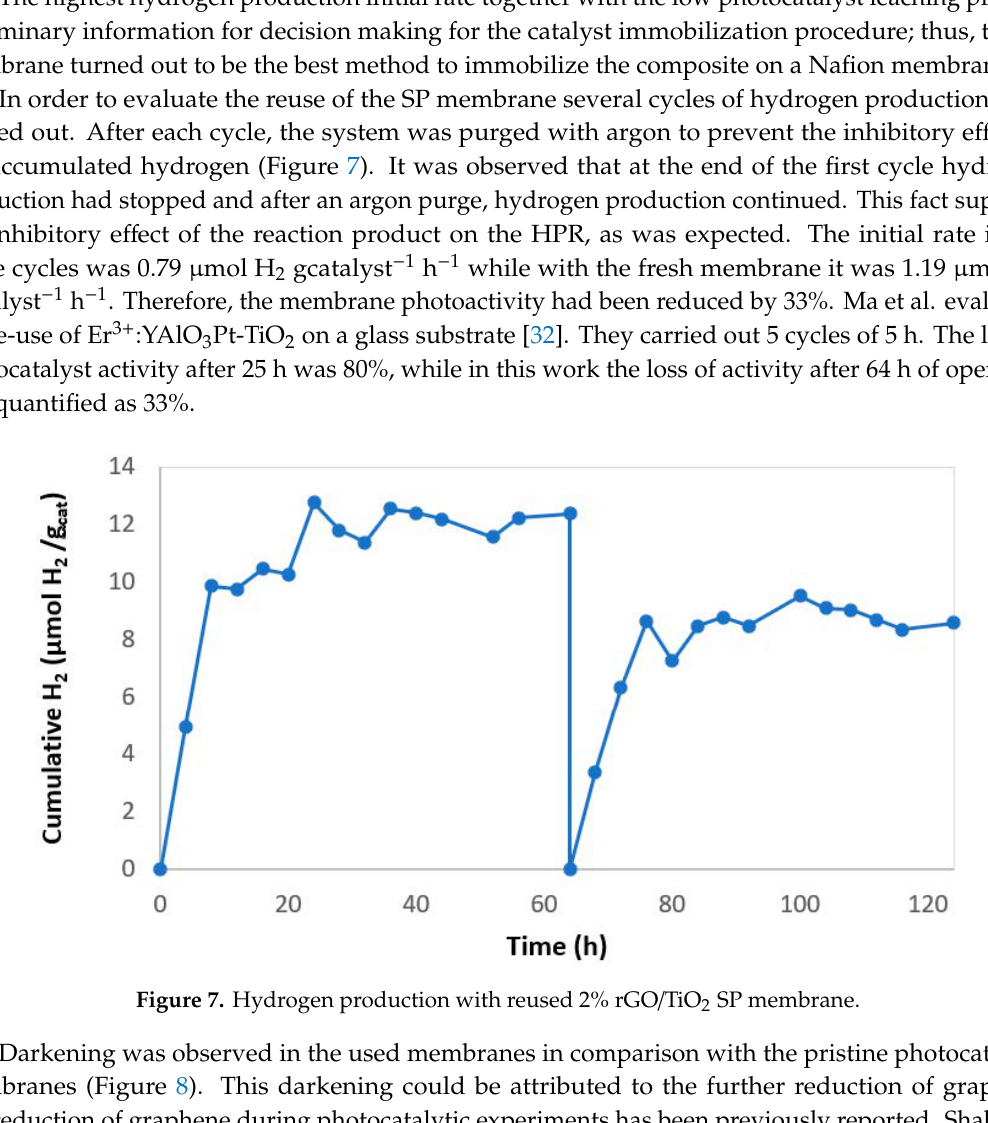
Figure 8. 2% rGO/TiO 2 membrane before (left) and after 96 h of use (right). 4. Conclusions Although there are environmental and energy advantages of photocatalytic hydrogen production, its large-scale application is still far from adoption, mainly due to the low performance and short lifetime of the state of the art photocatalysts. This work takes a step toward by advancing the knowledge on the application of immobilized composite photocatalysts. Cost-effective rGO/TiO 2 composite was synthesized showing improved photocatalytic properties compared to bare TiO 2 membranes. In addition, the influence of different process variables such as the composite immobilization method, SC, SP, and DP, to attach the catalyst to Nafion membranes was analyzed. SP and DP achieved the highest initial HPRs, about 1 µmol H 2 gcatalyst − 1 h − 1 . However, the SP method showed only 0.4% photocatalyst leaching after 80 h of operation, whereas DP leaching resulted in 4.8% at the same time. This fact could be due to a stronger photocatalyst attachment on the SP membrane surface than on the DP membrane surface. Therefore, SP seems to be the most effective method to immobilize the composite on Nafion membranes.